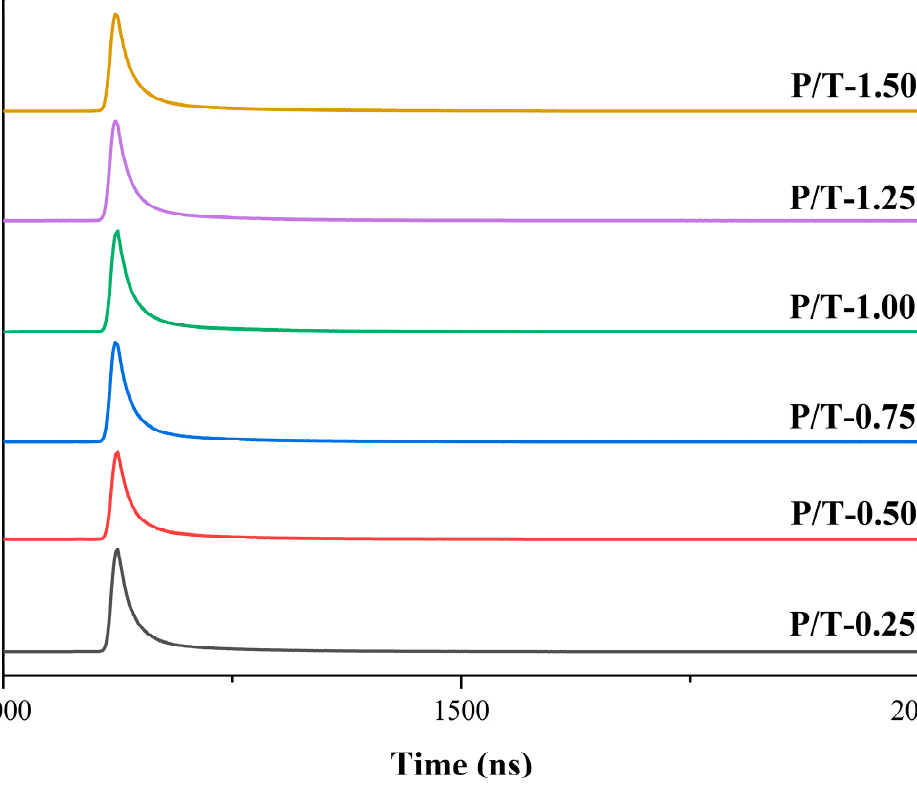
(cid:4593) ) curves of different initiator mass fractions samples; ( b ) the